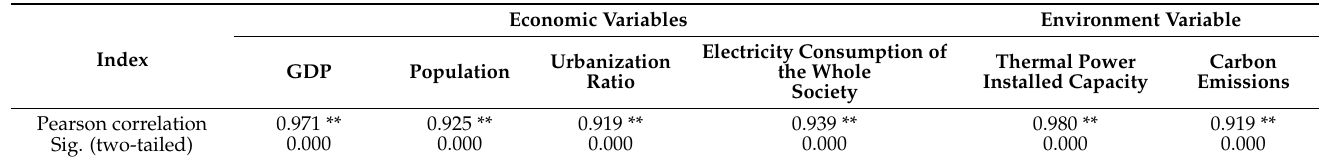
Table 1. Pearson coefficient correlation analysis